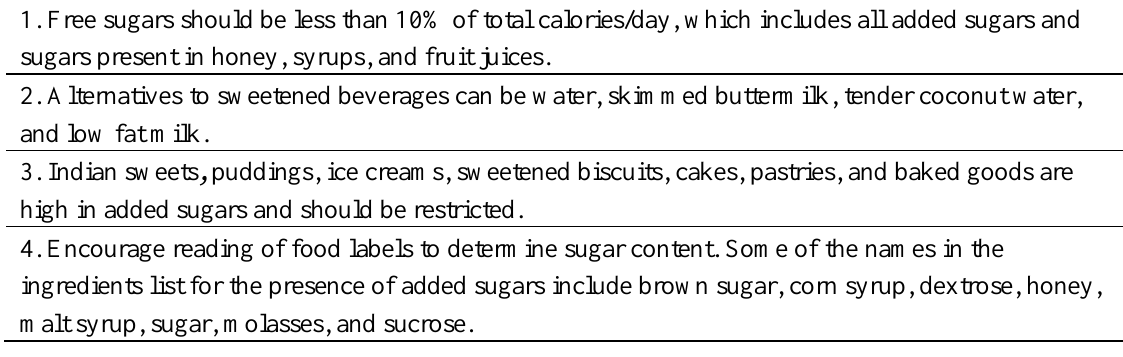
Table 7. Recommendations on sugar intake for Indians